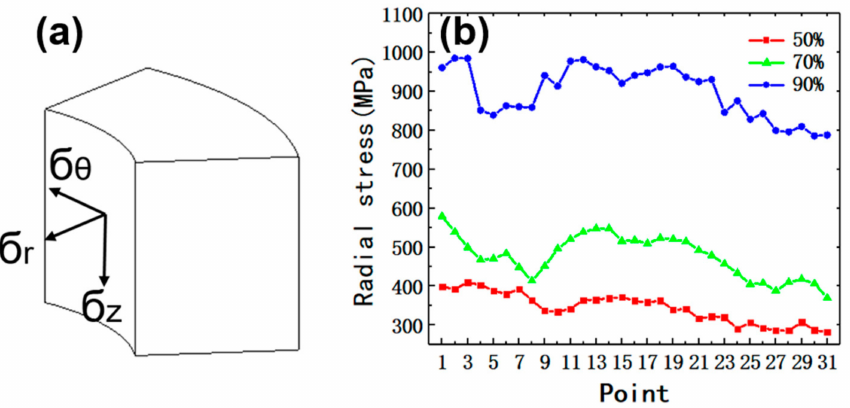
Figure 19. ( a ) Stress element in a cylindrical coordinate system, ( b ) radial stress at